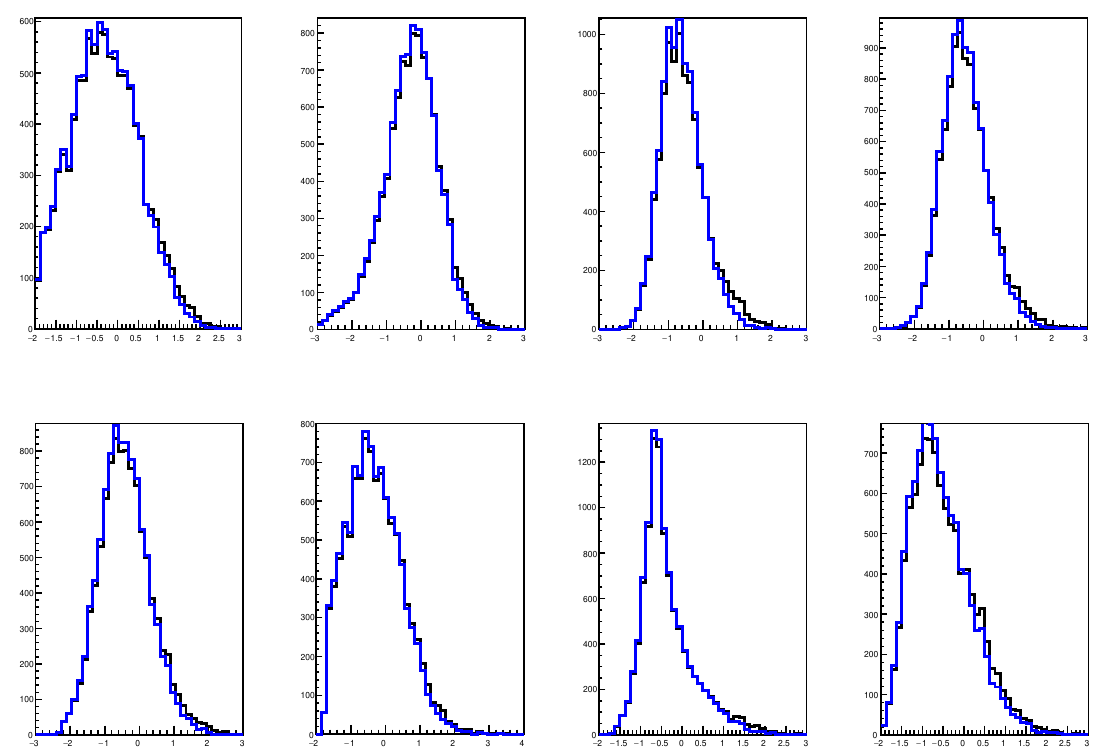
Figure 13 . Comparison of the standardized distributions of pure background (blue) and a mixture of 5% signal and background (black) in the most discriminating features in the HEPMASS dataset. Left to right, top to bottom: features 0, 3, 6, 10, 14, 18, 25, and